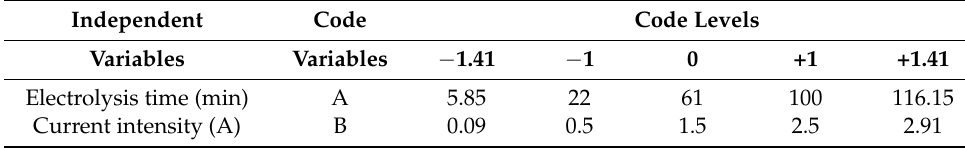
Table 1. Experimental domain of